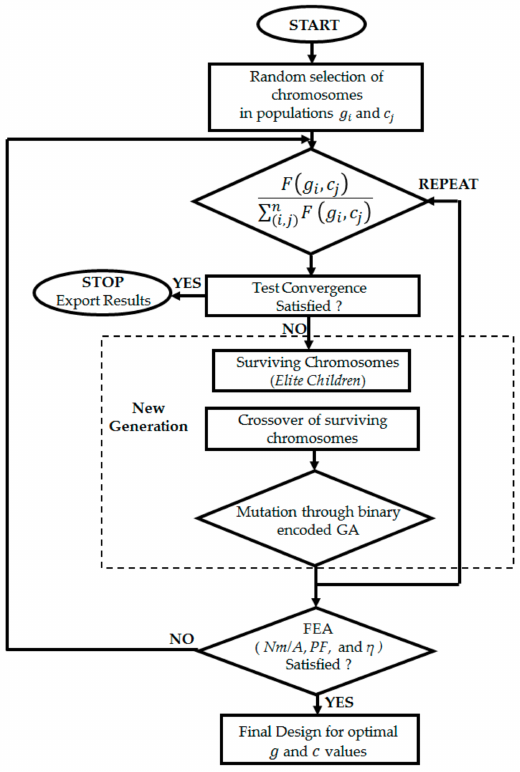
Figure 4. Flow chart of the design optimization process.